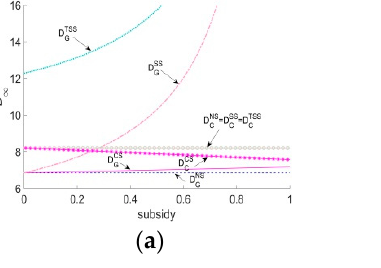
u on performances in the SS and TSS P